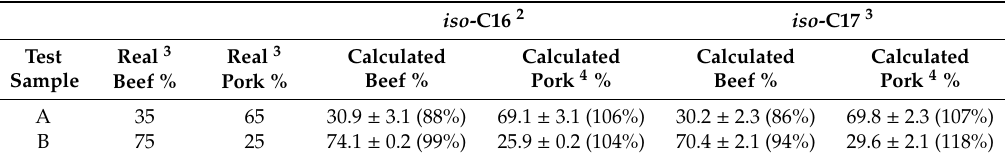
Figure 2. Linear trend observed for ( a ) CHFAs ( ω -11 CHFA (black) and ω -13 CHFA (orange)) and ( b ) iso -branched fatty acids (BCFAs) ( iso -C16:0 (black) and iso -C17:0 (orange)) concentrations in fresh minced meat or in Bolognese sauce with di ff erent ratios (0–100%) of beef and pork. Table 3. Beef and pork ratio calculations in the two blind samples of Bolognese sauce. Data are presented as the average of three independent replicates ± standard deviation. The trueness 1 values are reported in